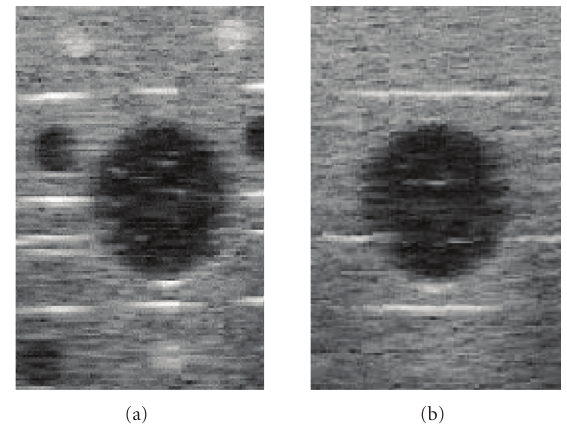
Figure 3: Compounded 3D volume for two orthogonal datasets: (a) cross-sectional view, (b) sagittal